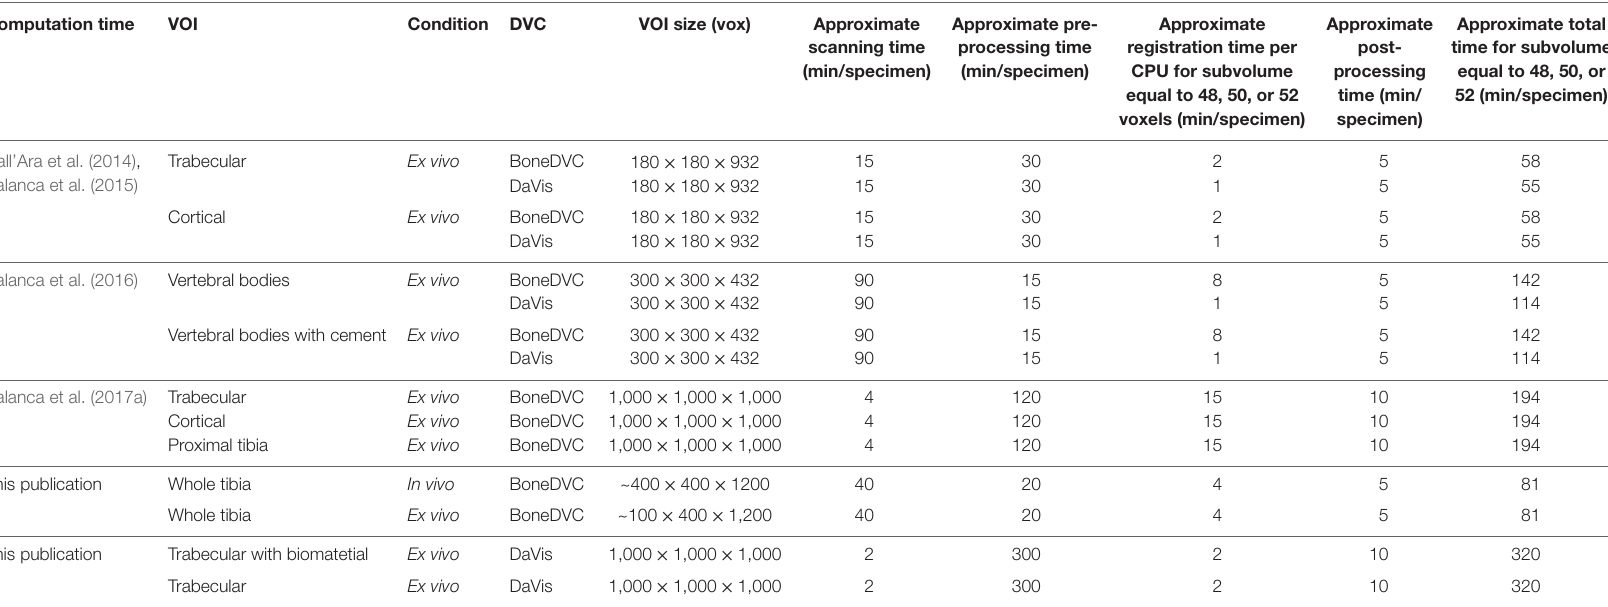
TaBle 5 | Estimated time required for the different applications split for the different parts of the procedure, from the scanning to the image pre-processing, digital volume correlation (DVC) running time, and post- processing of the results. computation time approximate